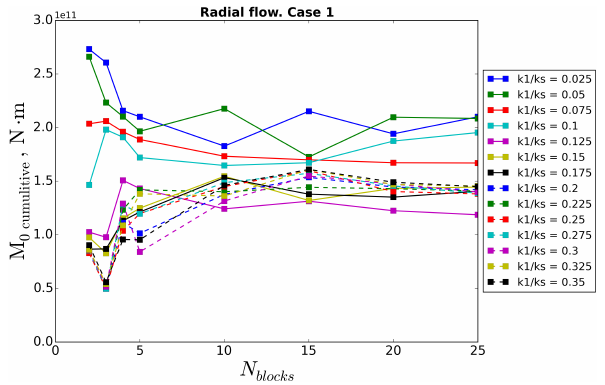
Figure 12. Cumulative seismic moment vs. number of blocks.